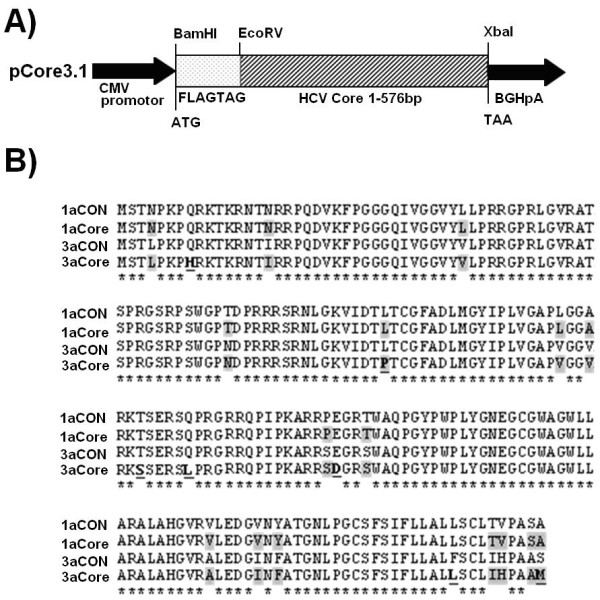
HCV Core expression plasmids and protein sequences comparison of HCV genotype 1a and 3a. A) Schematic diagram of HCV Core expression plasmid illustrating the FLAG tag sequences having ATG start site and with HCV3a and 1a Core (1-573 bp) sequence insertion into mammalian expression plasmid pCR3.1. The CMV promoter and BGHpA regions of pCR3.1 are also shown. (B) Amino acid sequence comparison of HCV Core 1a and 3a clones. Comparison of full predicted amino acid sequence of HCV Core isolates in our study against a consensus genotype 3a clone (3aCON) and 1a (1aCON) from the HCV sequence database, performed using the ClustalW program. Sequences different from consensus are boldface and underlined. Differences in the individual amino acid Core 1a and Core 3a are highlighted. Asterisks at the bottom of a sequence comparison indicate complete identity at that position.